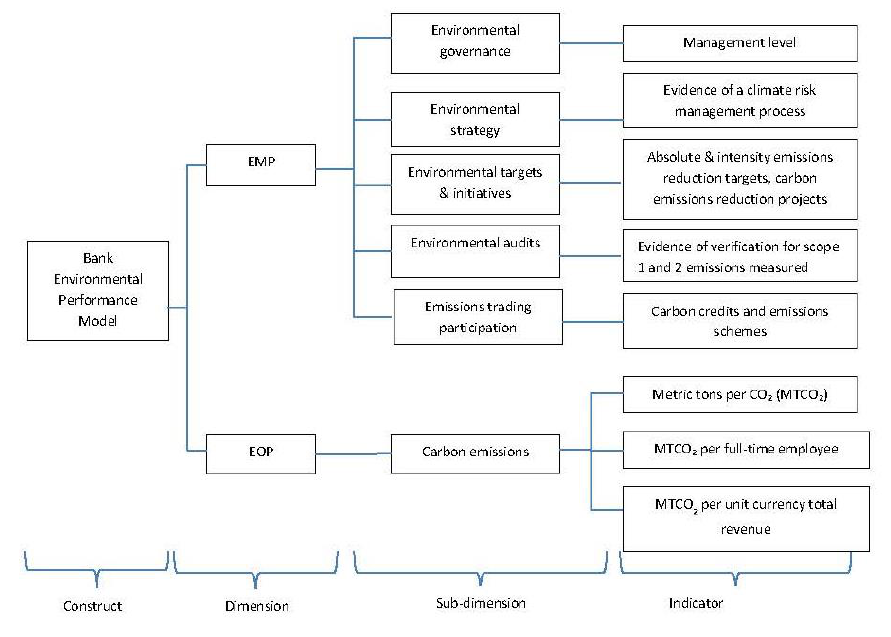
FIGURE 3: Proposed framework of Bank CEP Source: Authors’ deduction